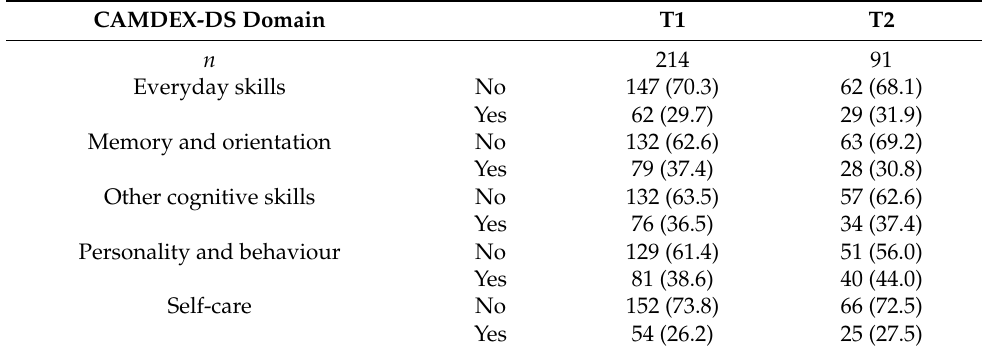
Table 2. Changes in CAMDEX-DS domain at T1 and